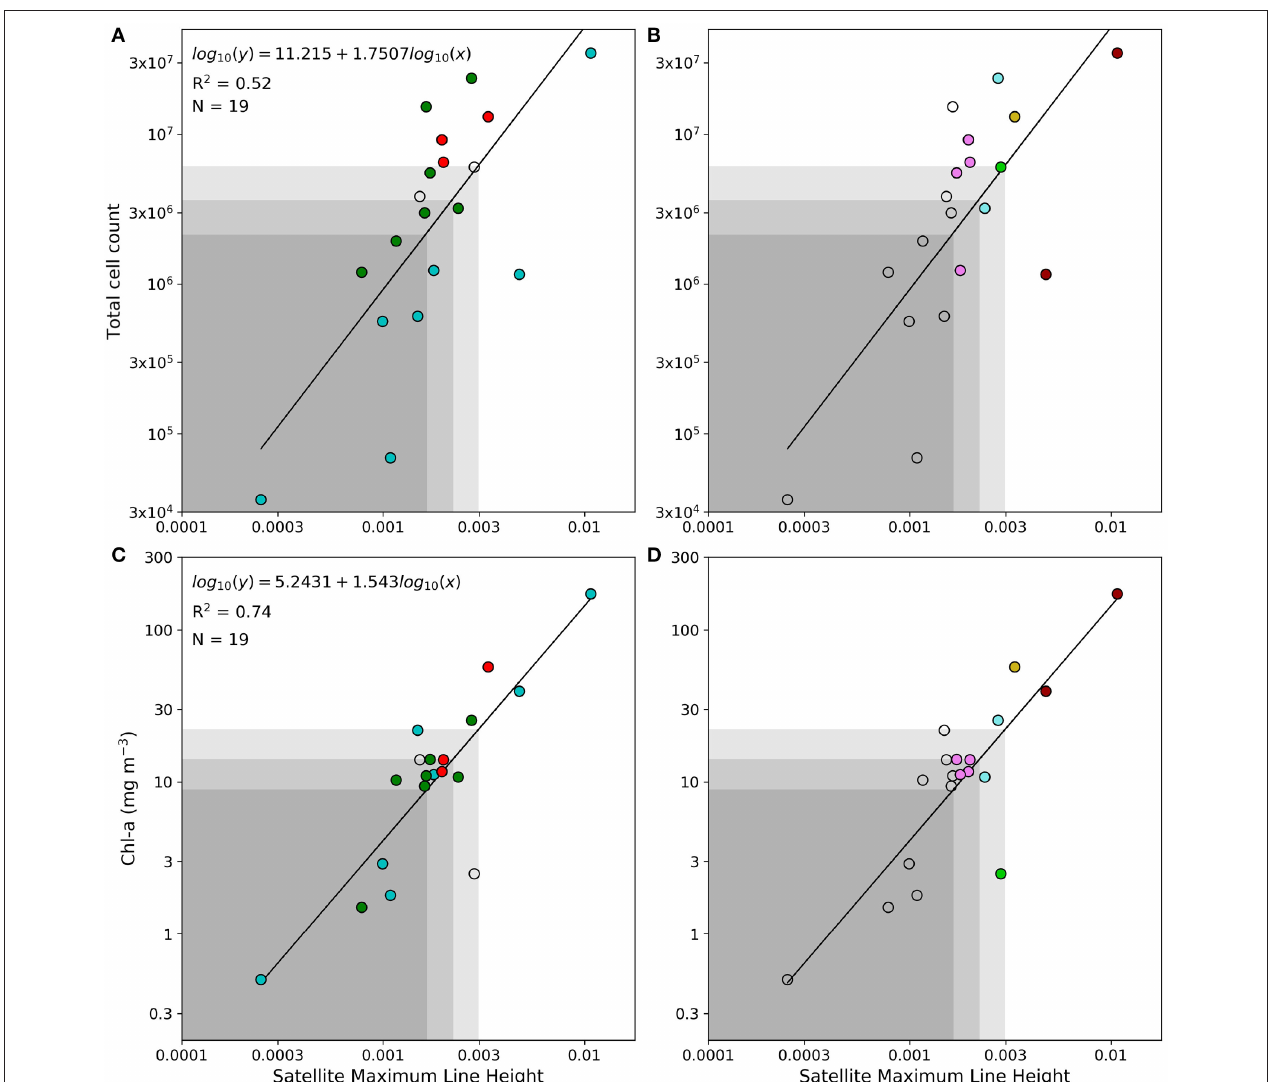
FIGURE 5 | (A–D) Linear regression analysis between maximum line height and in situ total cell counts (top) and between maximum line height and [Chl-a] (bottom) ; all data were log-transformed before analysis. The black line represents the regression line with the corresponding equation, coefficient of determination ( R 2 ) and the sample size ( N ). The shaded areas represent cell counts and [Chl-a] associated with MLH below 0.0016, 0.0022, and 0.003, respectively. Samples with more than 50% Pseudo-nitzschia , diatoms, or dinoflagellates are shown in red, green, and blue, respectively in the left panels. Right-hand panels show the classification of these samples using the satellite derived MLH and LHR. Please refer to Table 2 for a detailed color